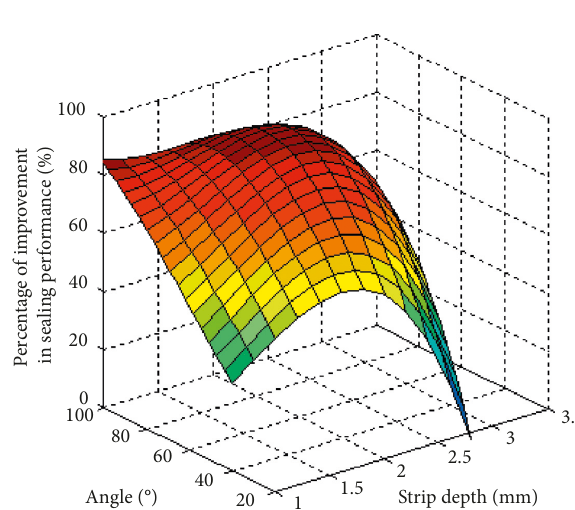
Figure 4: Influence of the striped structure on sealing performance of the mud pump piston.